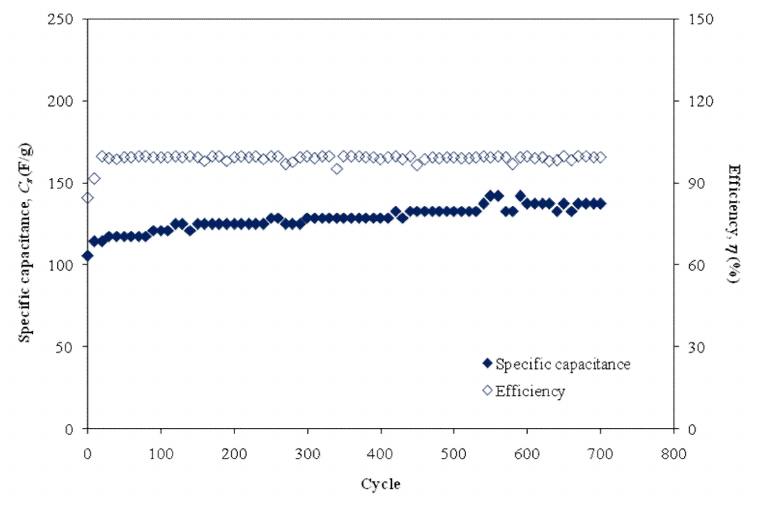
Figure 10. Specific capacitance, C s , and e ffi ciency, η , of the fabricated EDLC for 700